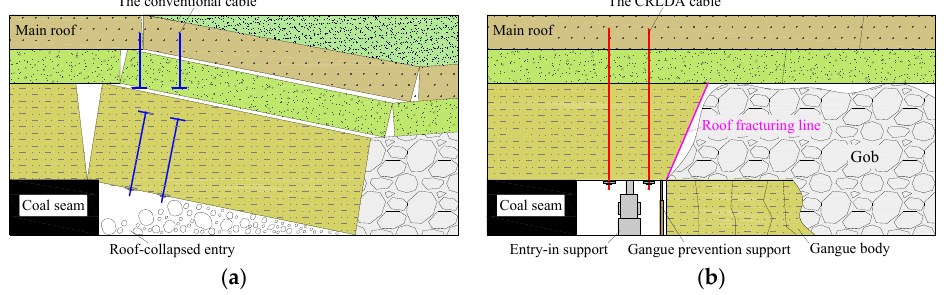
Figure 3. Principle of the FRME approach: ( a ) No roof fracturing and reinforced support. The conventional anchor cables fail, and the entry collapses. ( b ) With roof fracturing and reinforced support. The entry is retained under active support.